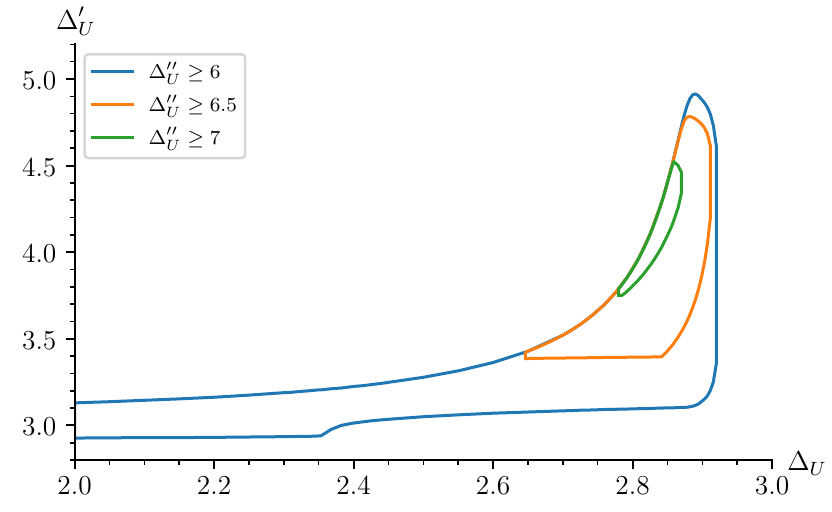
Figure 7 . Allowed values of ∆ U versus ∆ 0 , the dimensions of the first two multiplets in the ϕ × ¯ ϕ U and M × M OPEs. We assume that these are the only two operators below ∆ 00 ≥ { 6 , 6 . 5 , 7 } and U the parameters ∆ ϕ , c , k are fixed to the values of the rank-one H 1 theory. The allowed region is enclosed between the upper and lower curves. The numerical optimization is using Λ = 24